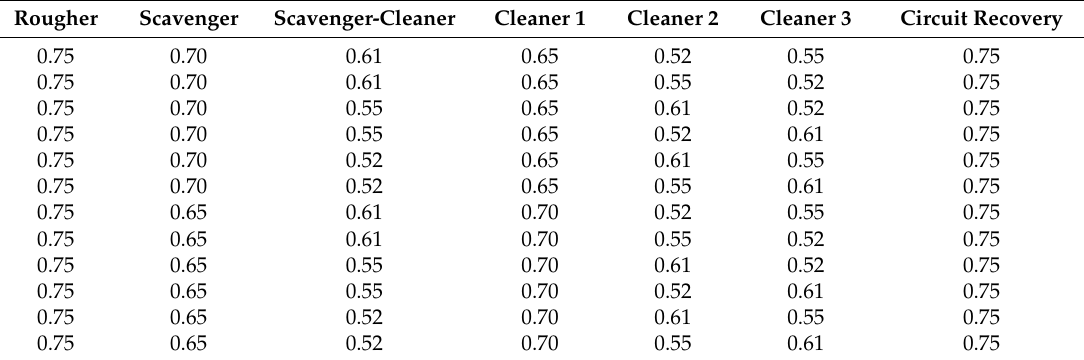
Table 4. Maximum circuit recovery with regard to stage recoveries.